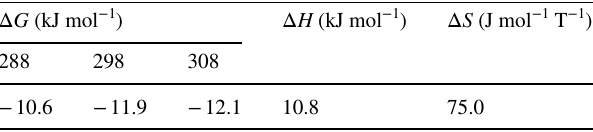
Table 4 Thermodynamic parameters of paracetamol adsorption